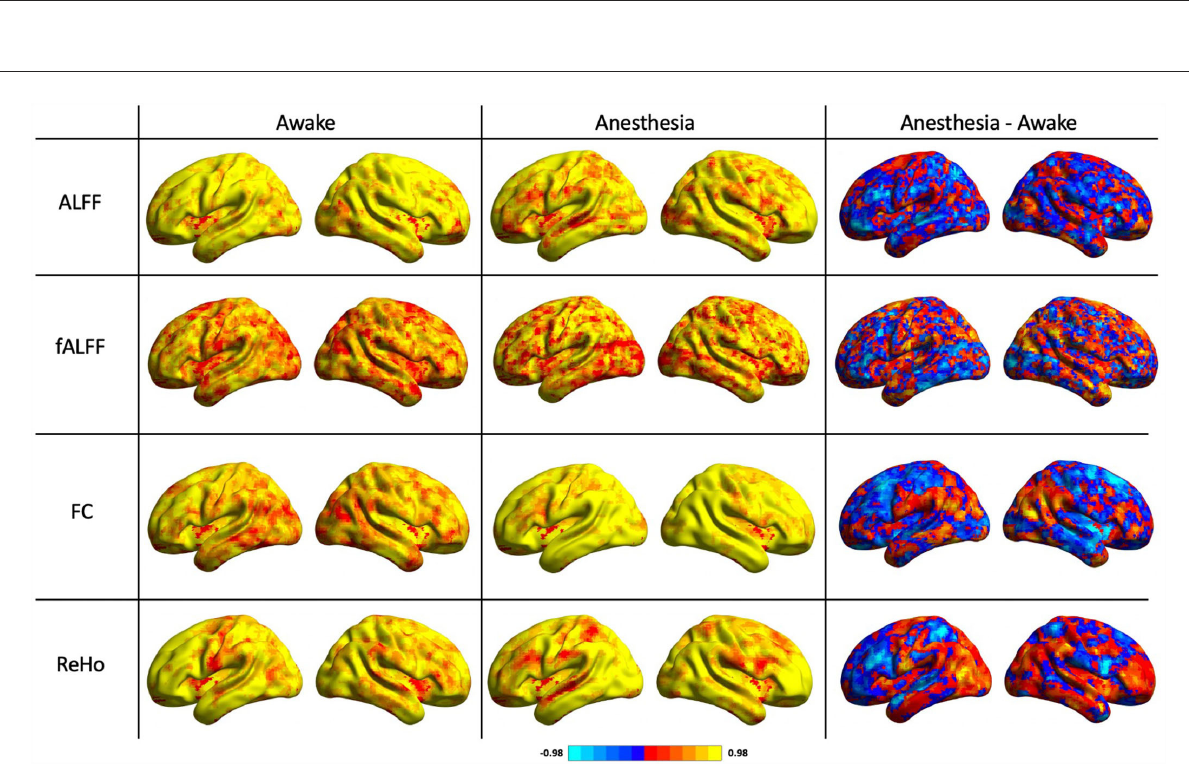
FIGURE5 Means and error bars of ICC for the amplitude of low-frequency fluctuation (ALFF), fractional amplitude of low-frequency fluctuation (fALFF), functional connectivity (FC), and regional homogeneity (ReHo) over 1 to 15min scan